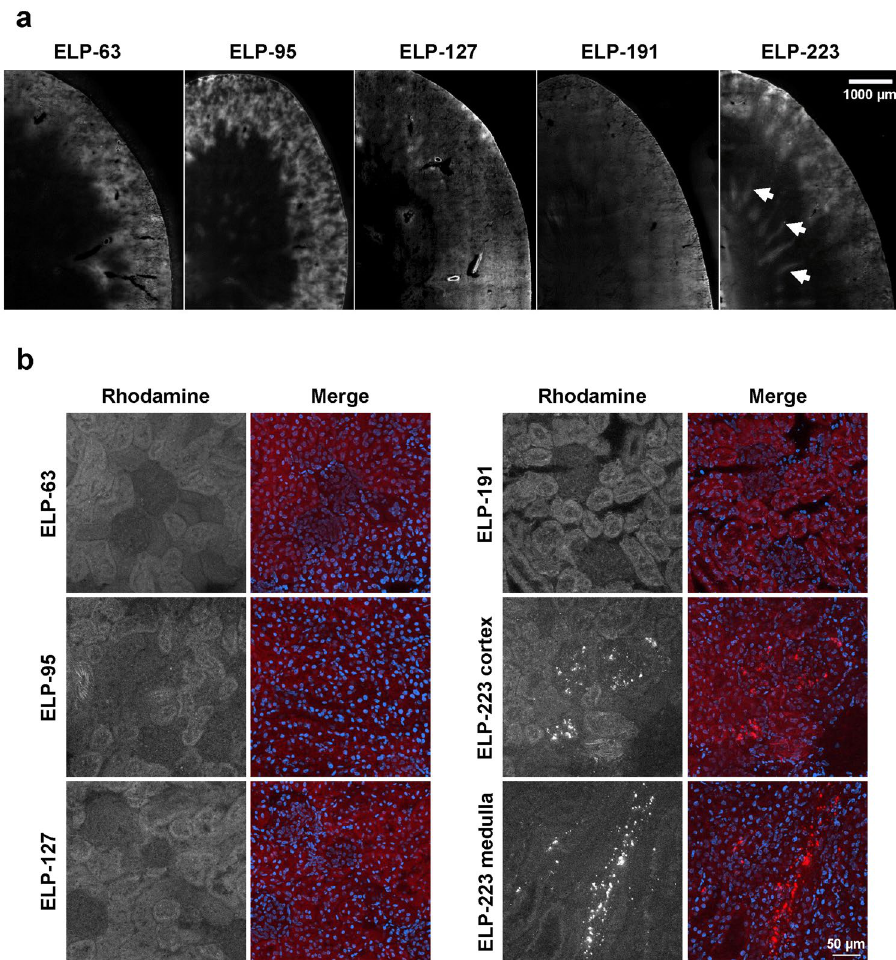
Figure 6. Intrarenal Distribution of ELP Constructs. ( a ) Intrarenal localization of ELPs in kidney sections obtained by confocal microscopy image stitching, scale bar 1000 µ m. ( b ) Intrarenal localization of ELPs in kidney sections stained with Hoechst 33342 and imaged by confocal microscopy, scale bar 50 µ m. Brightness levels were adjusted to optimize image quality and do not represent actual